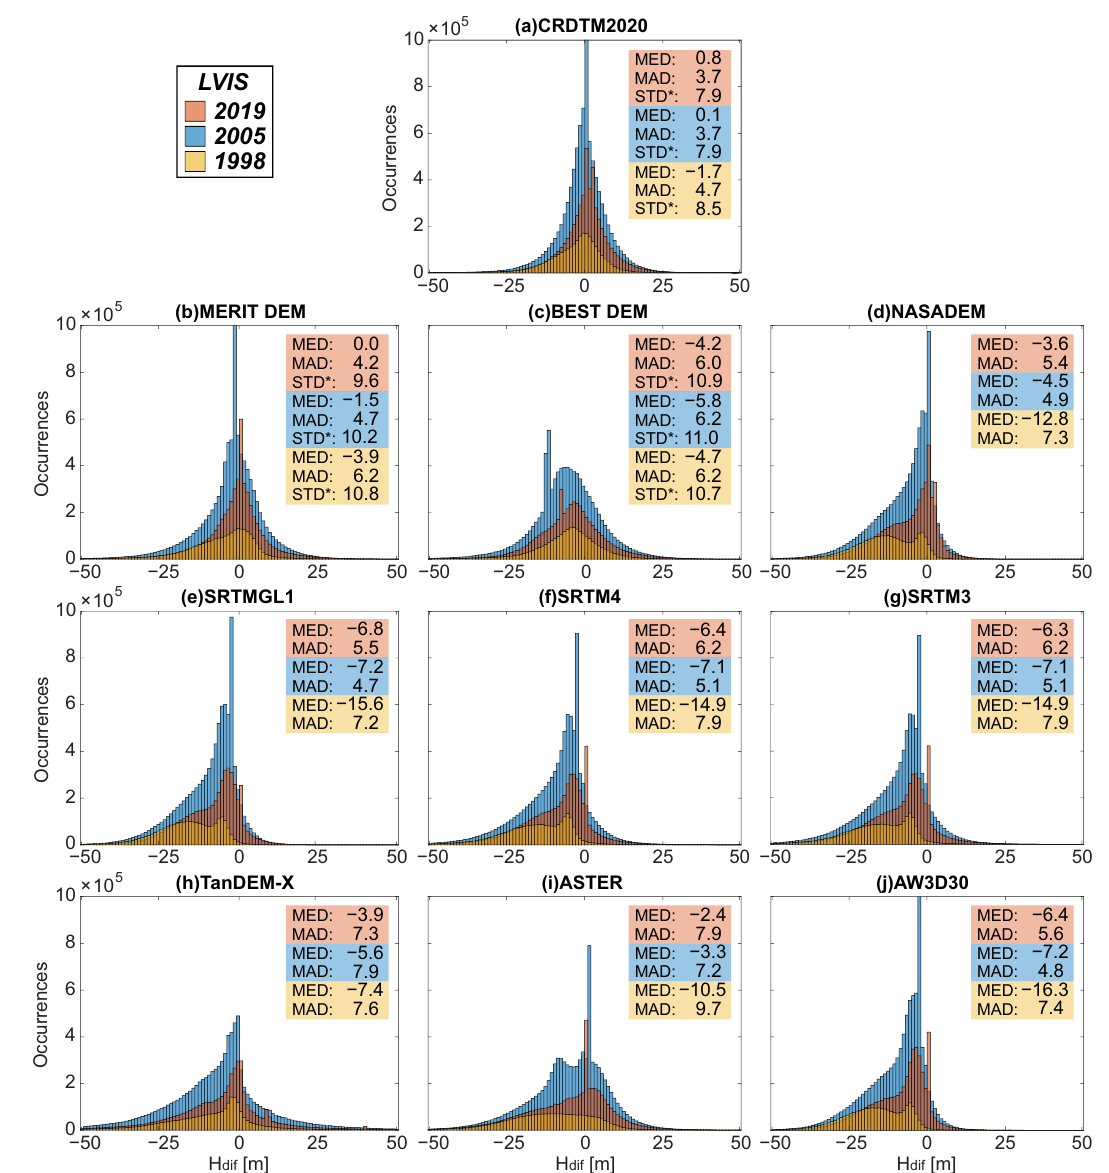
Figure 15. Histograms of height differences ( H dif ) between points of LVIS2019 (orange), LVIS2005 (blue), and LVIS1998 (yellow) ground elevations ZG and ten DEMs. Histograms are presented with a threshold of ± 50m for the height difference ( H dif ) and over the same vertical axis for occurrences to facilitate visual interpretation. The statistics is provided in terms of the Median Difference (MED), Median Absolute Difference (MAD), and Standard Deviation